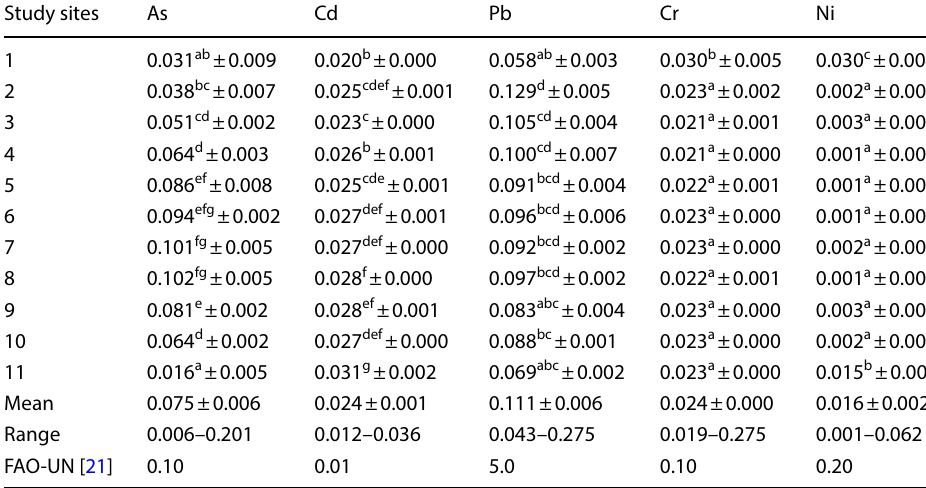
Table 4 Heavy metals concentration (ppm) in irrigation water of the cold desert high-altitude trans- Himalayan region